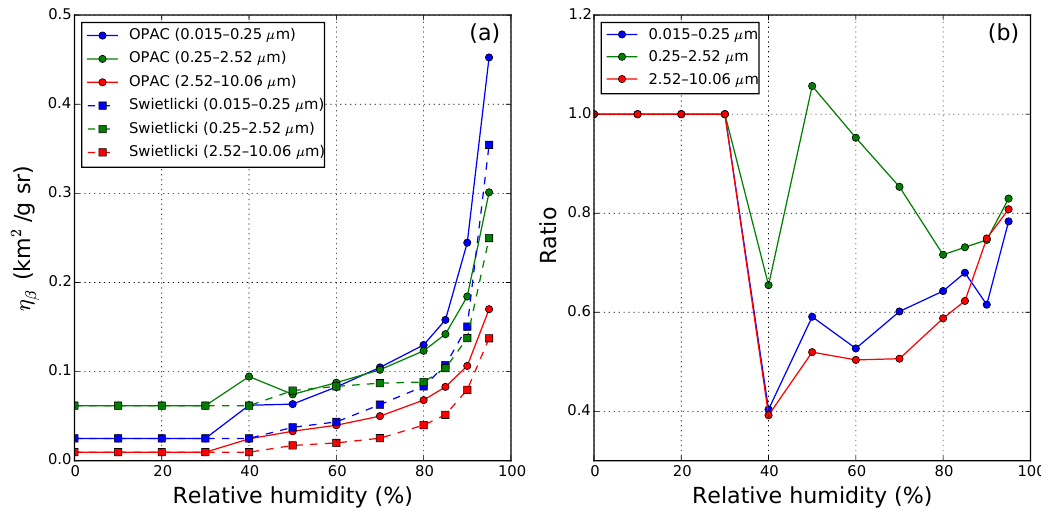
Figure 6. (a) Mass mixing ratio to backscatter coefficient conversion factors η β,i of sea salt aerosol for the small, medium and large size bins (in blue, green and red) at different ambient relative humidities. Hygroscopic growth factors of sea salt are taken from the model assumption (solid circle curve) and Swietlicki et al. (2008) (dashed square curve). The ratios of mass mixing ratio to backscatter coefficient conversion factors between the hygroscopic growth effects taken from Swietlicki et al. (2008) and OPAC databases are shown in panel (b) ; ratios smaller than 1 indicate an reduction when using hygroscopic growth from Swietlicki et al.